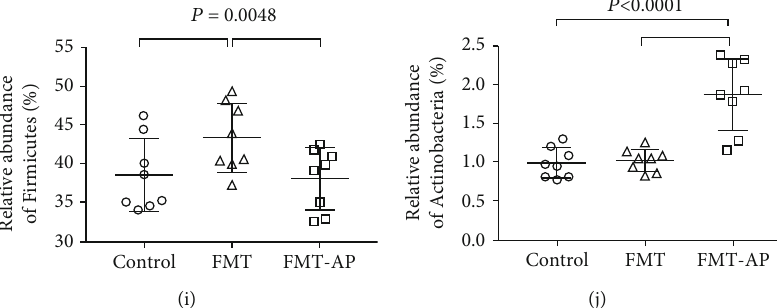
Figure 4: In vivo inhibition of tumor growth following fecal transplants. Number (a) and size (b) of colon tumors in the FMT ( n = 8 ) and FMT-AP ( n = 8 ) groups; (c) change in body weight, (d) histological scores, (e) OTU number, (f) diversity indexes, (g) the abundance of gut microbiota at the phylum level, and the relative abundance of (h) Bacteroidetes, (i) Firmicutes, and (j) Actinobacteria in the fecal microbiota transplantation (FMT) experiment; n = 8